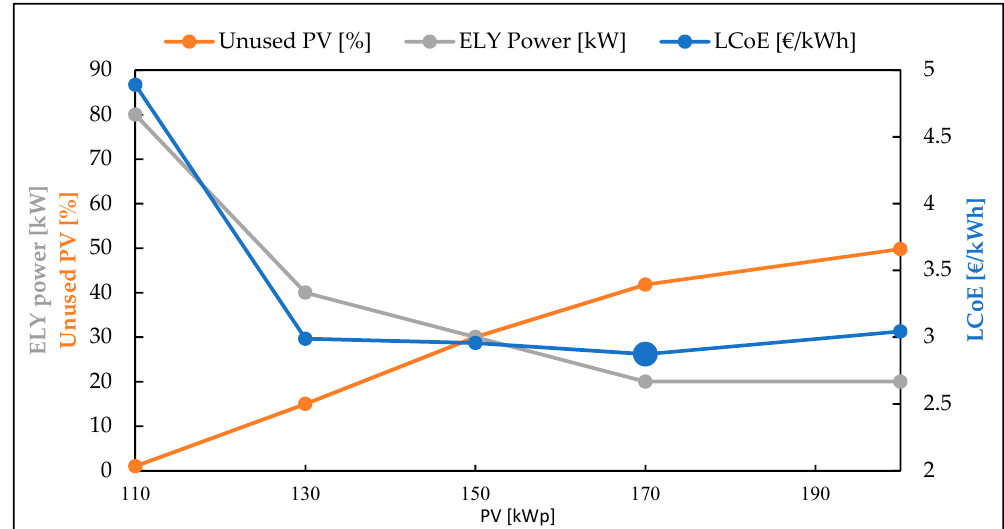
Figure 6. PV-Bat-H 2 system in Edinburgh with a 4 kW steady load.